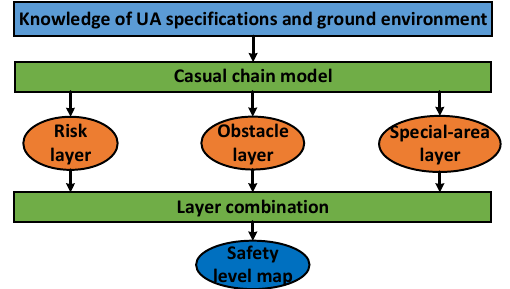
Figure 1. Method framework.